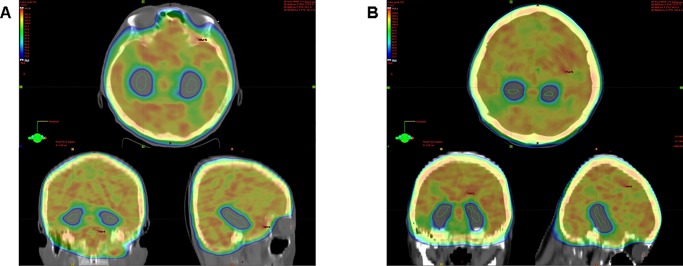
An example of dose distribution in axial, sagittal, and coronal view.(A) the supine and (B) head-tilt position of volumetric-modulated arc therapy.